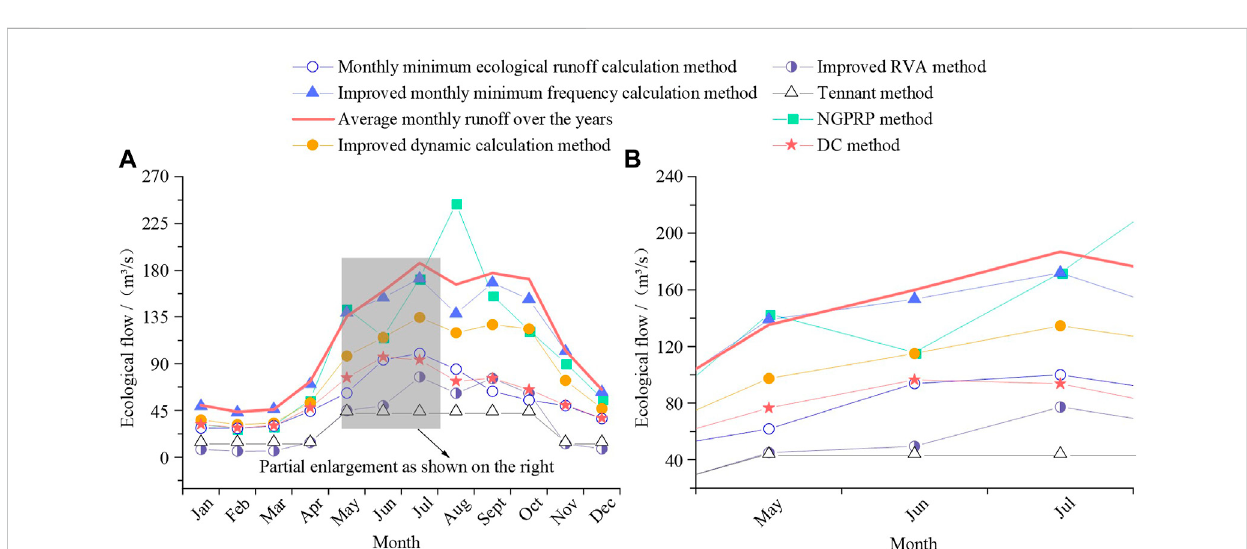
FIGURE 4 Ecological fl ow for each month of the year calculated by various methods at Wudu Hydrological Station. (A) shows the ecological fl ow values calculated by seven methods. (B) shows the ‘ abrupt change ’ in ecological fl ow calculated by various methods for the months of